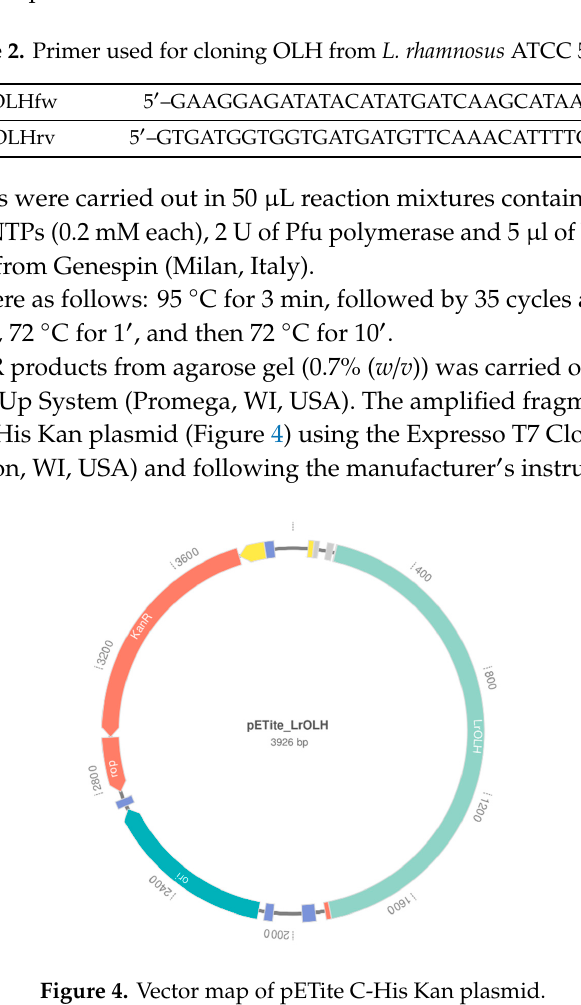
Figure 4. Vector map of pETite C-His Kan plasmid.